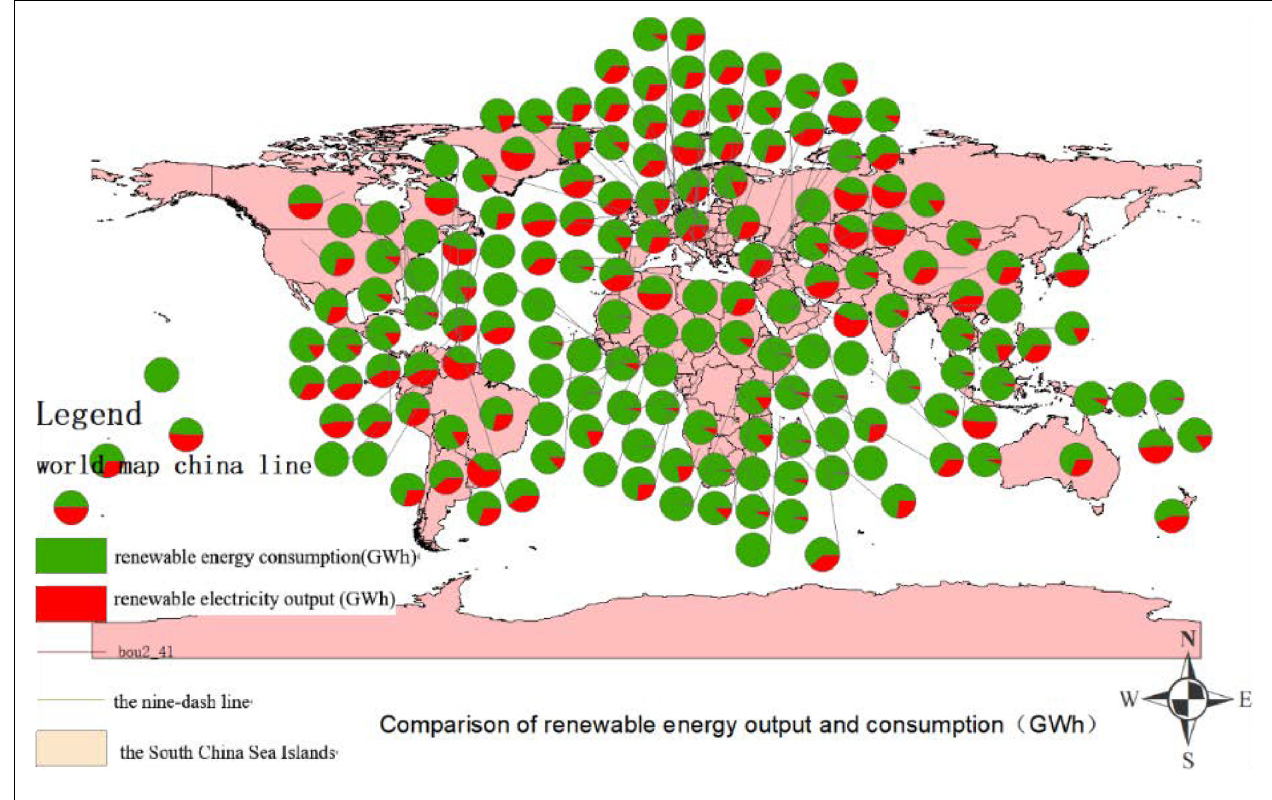
FIGURE 6 | Comparison of renewable energy output and consumption